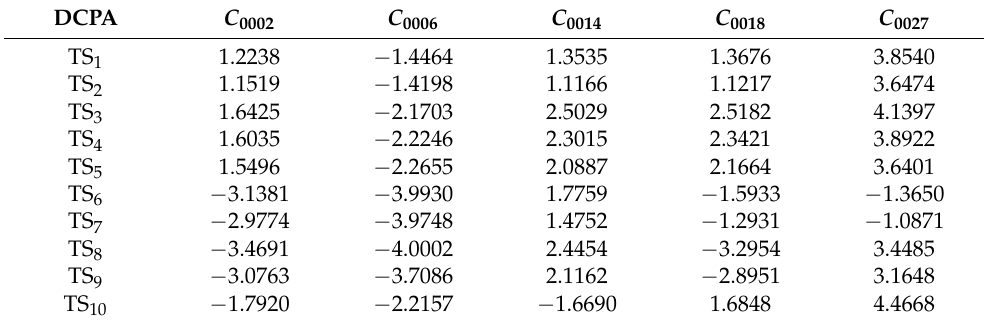
Table 10. DCPA of target